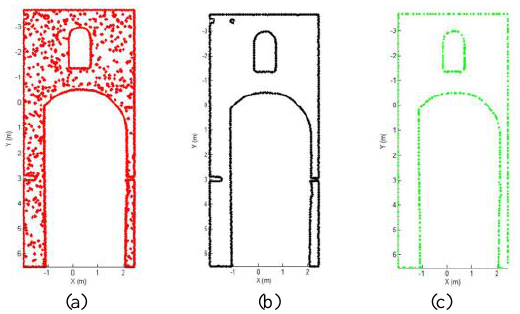
Figure 17. Choice of the contour points extraction threshold; a) underestimated ( ds = 4 cm); b) correct ( ds = 7 cm); c) overestimated ( ds = 20